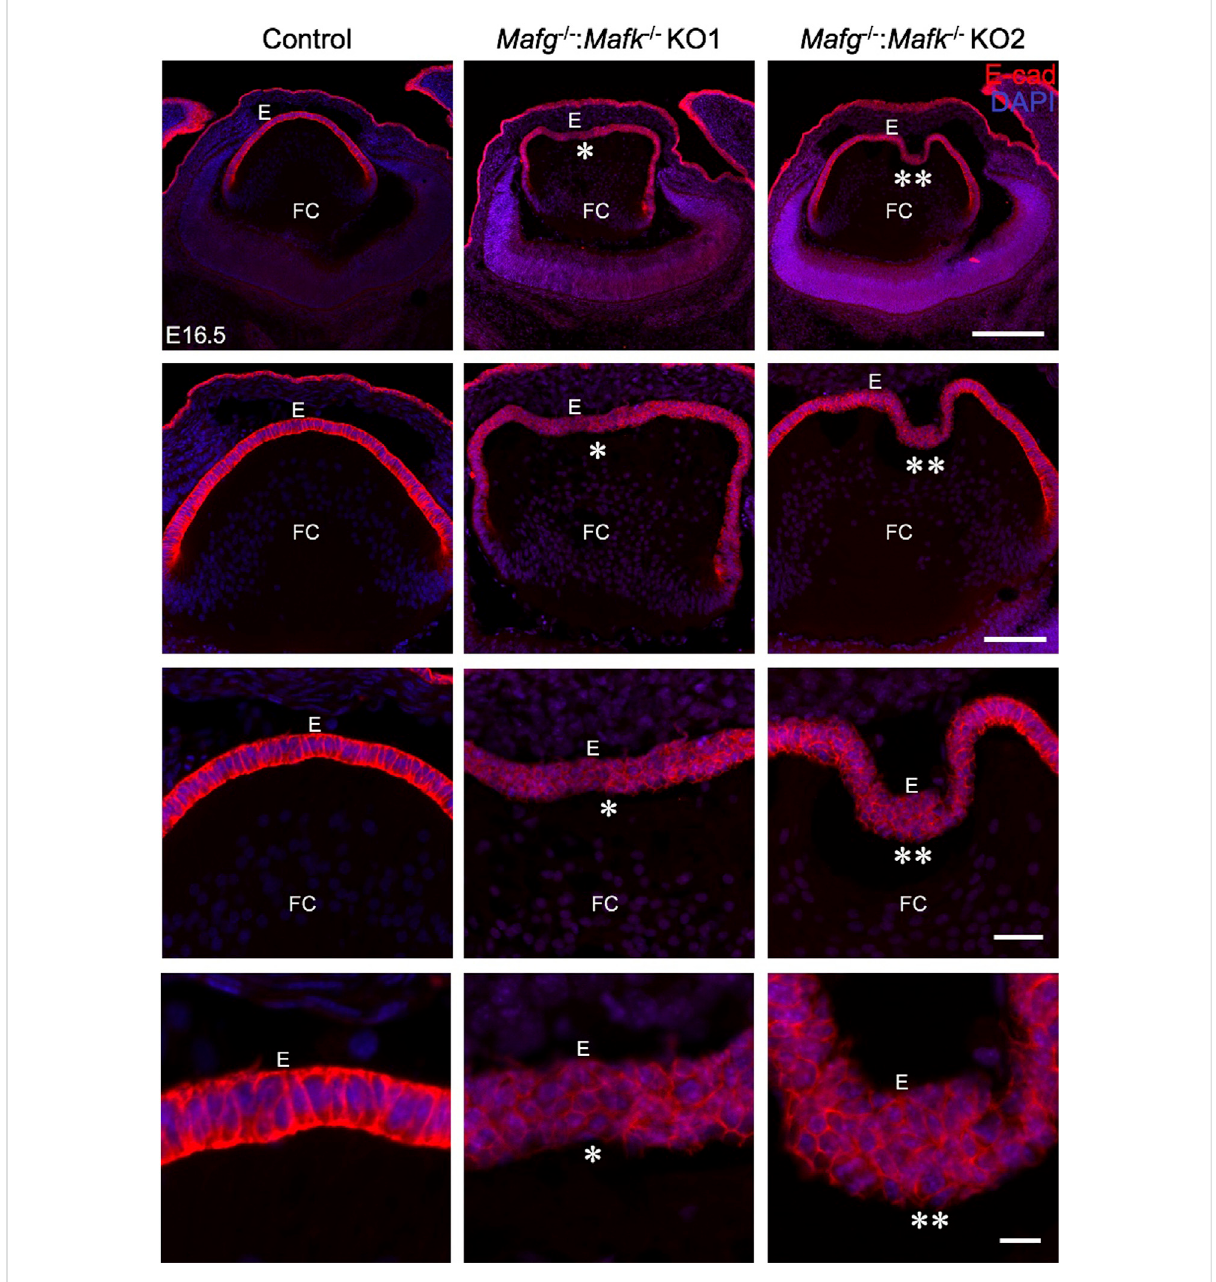
FIGURE 1 Mafg and Mafk de fi ciency results in an abnormally multilayered epithelium of the lens. Immunostaining for E-cadherin reveals cellular abnormalities(indicatedbyasterisks)inthelensepitheliumof Mafg − / − : Mafk − / − butnotcontrolatembryonicday(E)16.5. Mafg − / − : Mafk − / − KO#1andKO #2areshownasrepresentativeoftheseverityofepithelialdefects.Sectionsareco-stainedwithDAPIforvisualizationofnuclei.Highermagni fi cation images in row 2 (20X), row 3 (40X), and row 4 (63X) demonstrate the variable extent of multilayered epithelium in the Mafg − / − : Mafk − / − lenses comparedtocontrol.Abbreviation:E,Epitheliumofthelens;FC,Fibercellsofthelens.ScalebarforRow1,10 μ m;Row2,20 μ m;Row3,10 μ m;Row 4, 8 μ